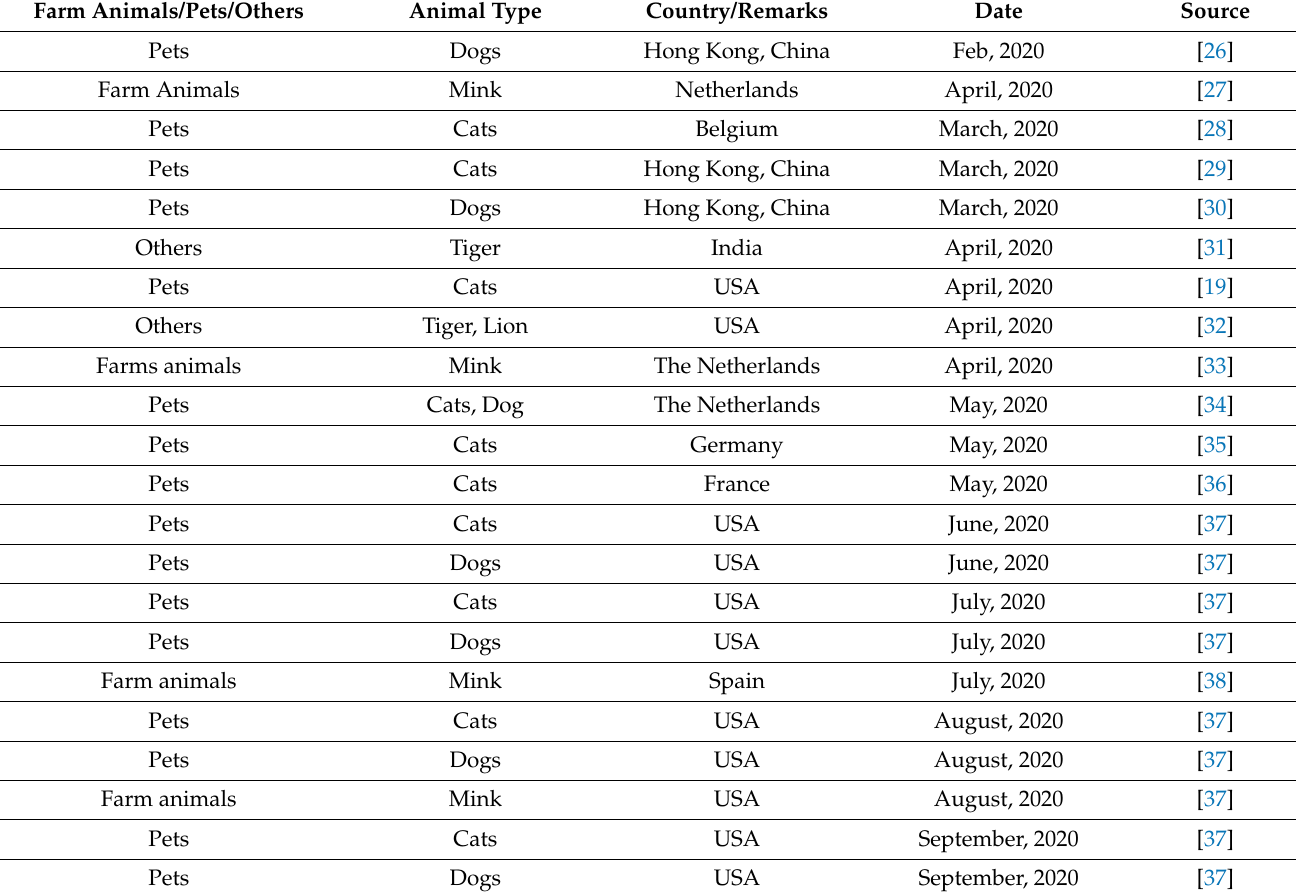
Table 1. Summarized reports of COVID-19 infections in animals based on reported